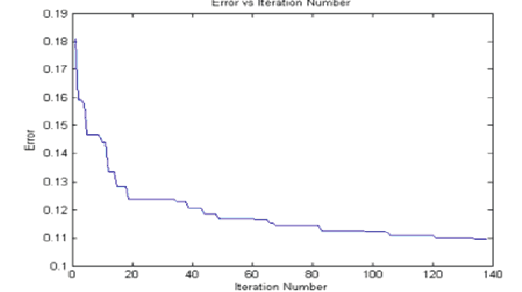
Figure 8: Ionosphere-Iteration vs. Error Figure 9 illustrate the classification accuracy trends with respect to different noise level in the datasets.